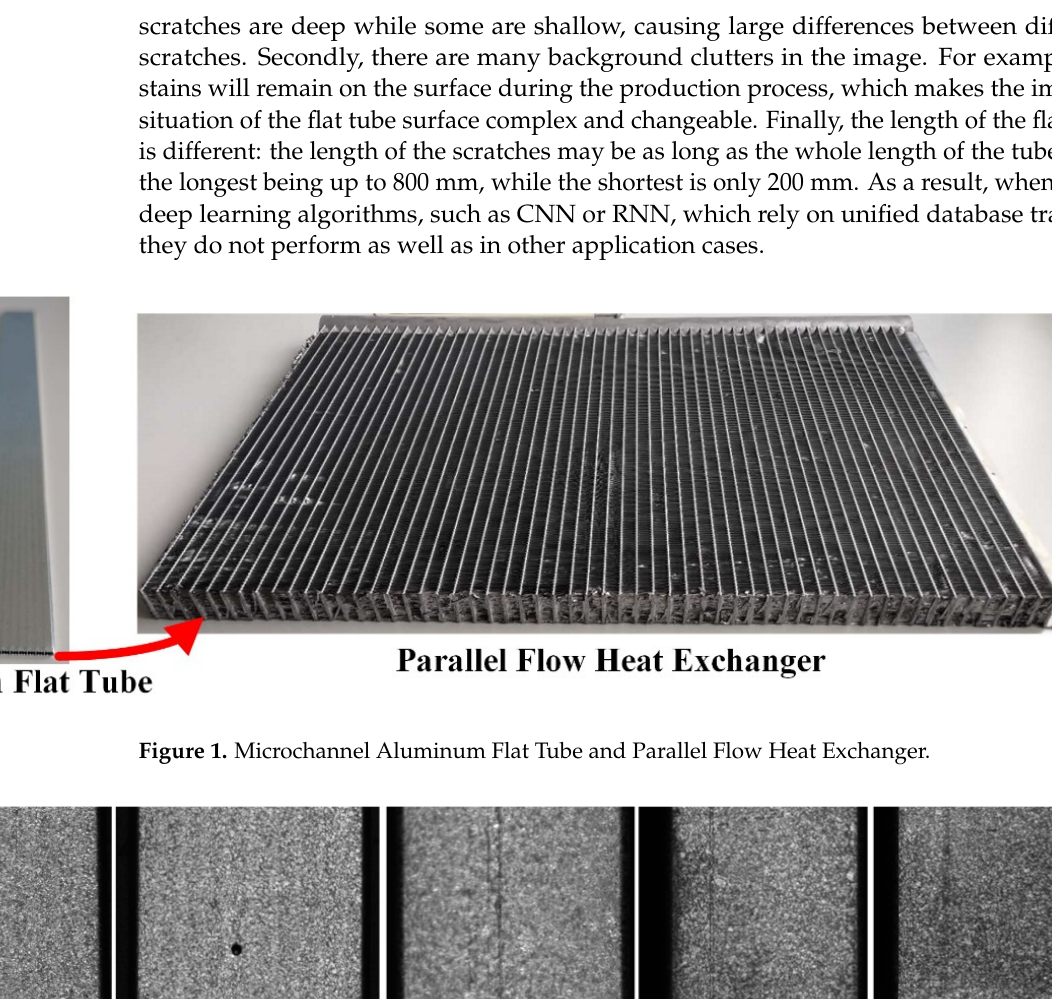
Figure 2. Examples of surface defects.